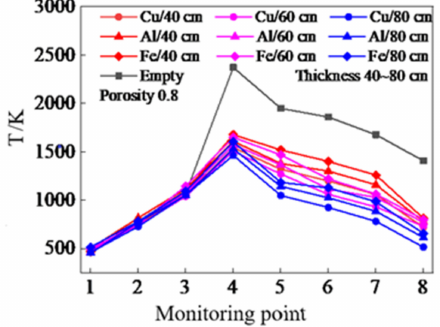
Figure 9. Maximum temperature at each monitoring point.